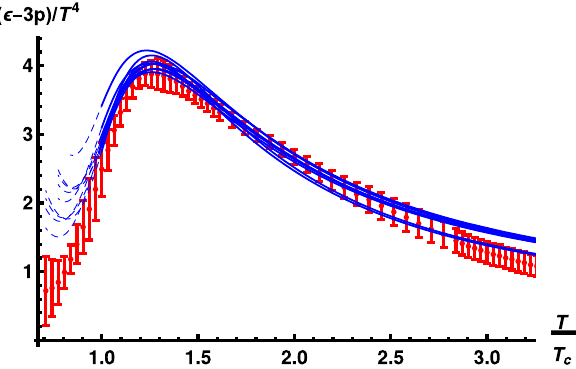
Fig. 7 Fitting V f 0 (λ) to the QCD lattice data for the interaction mea- sure. The red dots and error bars show the lattice data [285], and blue curves are our fits. Figure taken from